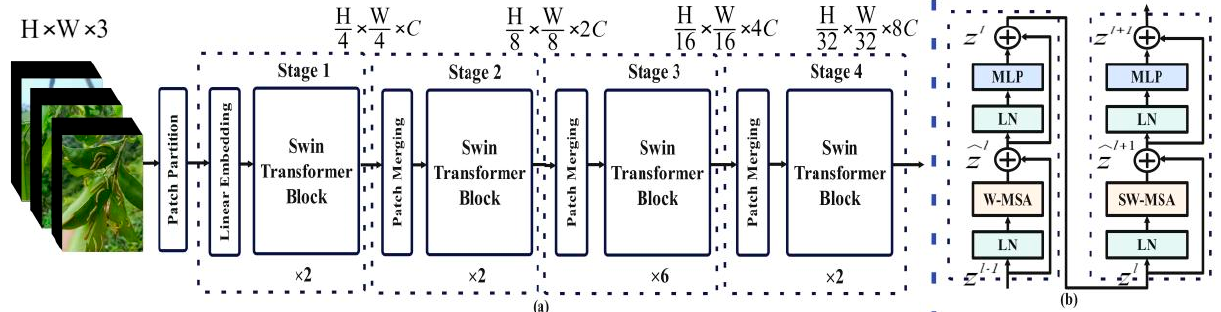
Figure 3. ( a ) The architecture of a Swin Transformer; ( b ) two successive Swin Transformer Blocks (notation presented with Equation (3)). W-MSA and SW-MSA are multi-head self-attention modules with regular and shifted windowing configurations, respectively.